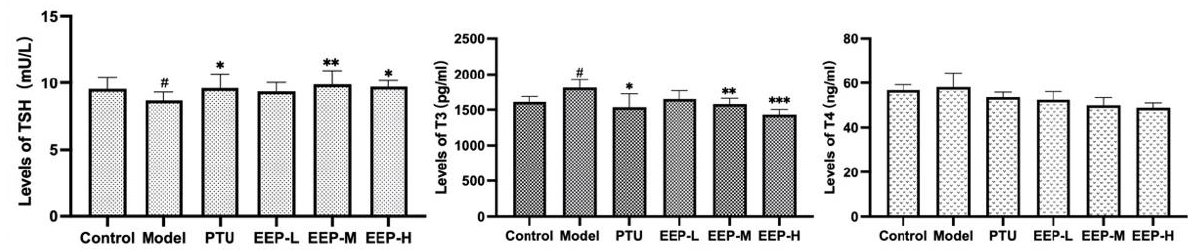
Figure 3. Effect of EEP treatment on thyroid hormone levels in mice with hyperthyroidism status. Data are presented as mean ± SEM ( n = 8). # p < 0.05versus Control; * p < 0.05, ** p < 0.01 and *** p < 0.001 versus Model.